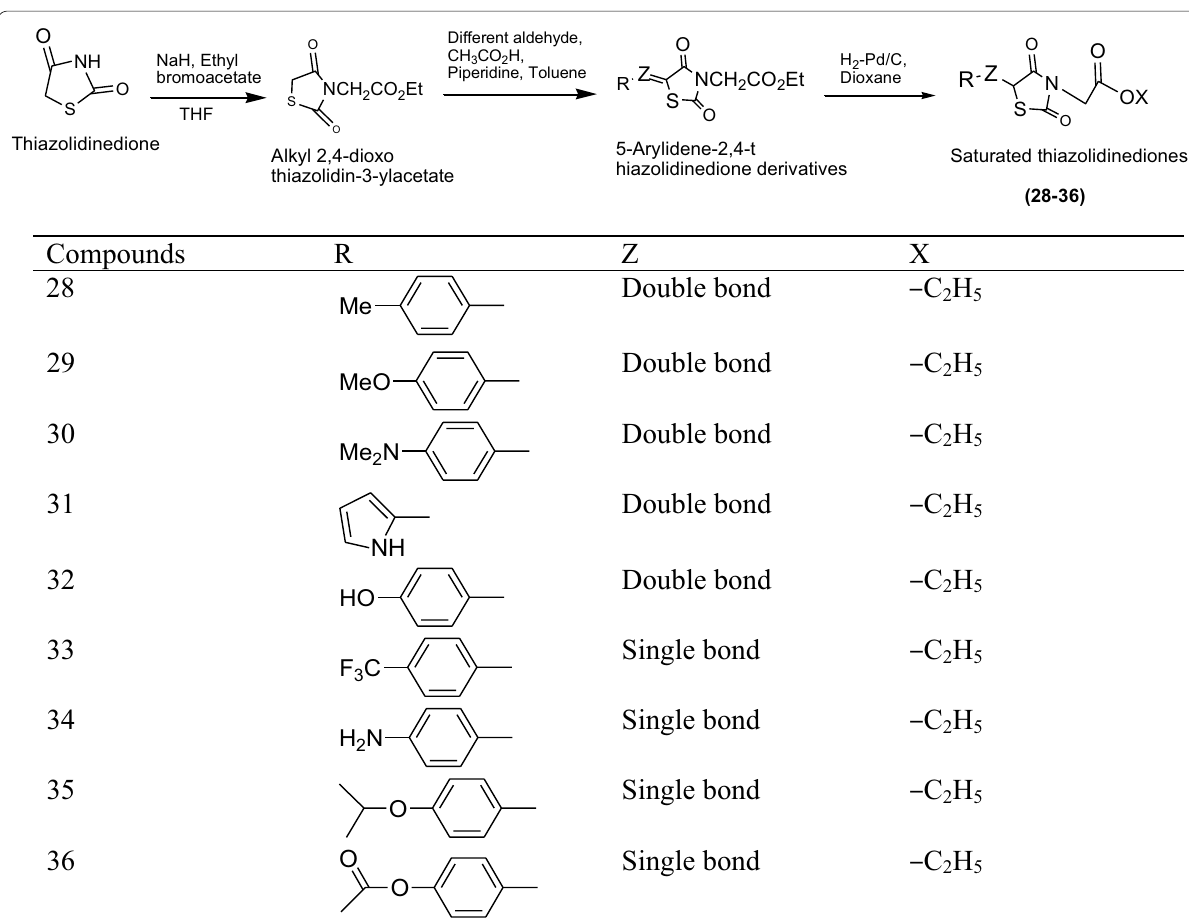
Table 11 Antihyperglycemic activity profile of title com- pounds thiazolidine-2,4-dione derivatives Compounds Antihyperglycemic activity,